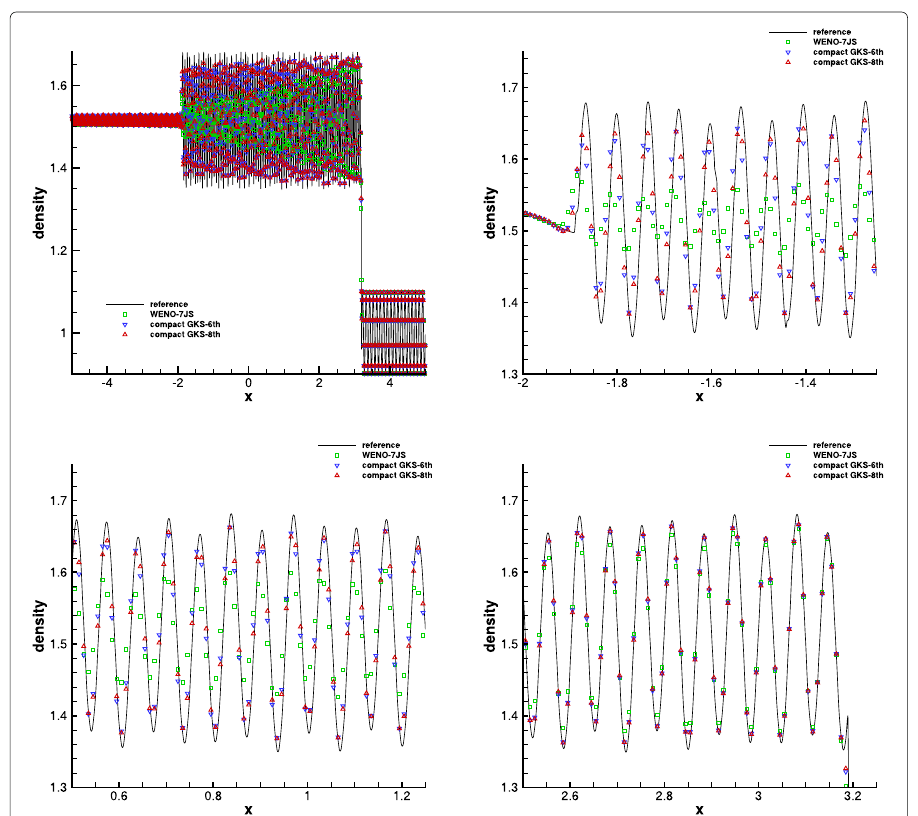
Fig. 6 Titarev-Toro problem: the density distribution and local enlargement by 6th-order and 8th-order compact GKS at t = 5 with 1000 mesh